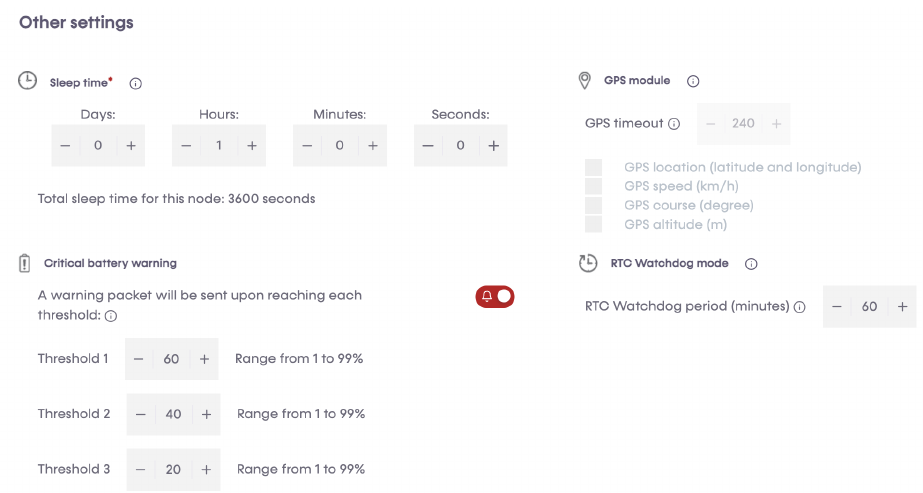
Figure 10. Setting up communication and protocol destination block.